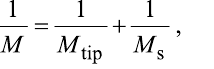
Figure 6: FEM simulation of indentation modulus for three different step heights by using a flatpunch indenter ( A 2 = 1.232 nm 2 ).